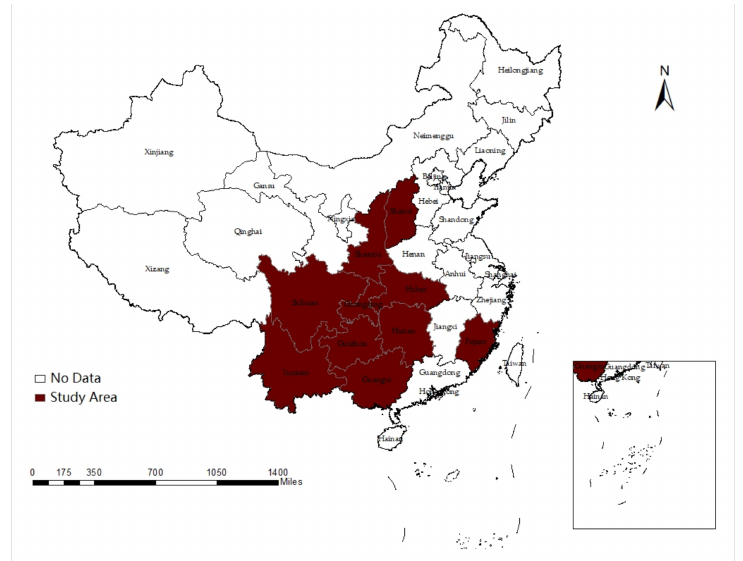
Figure 2. Location of the study area.